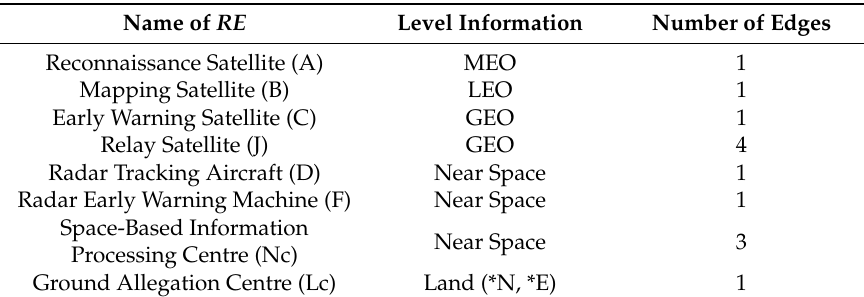
Table 2. R-SIN Architecture Data List.